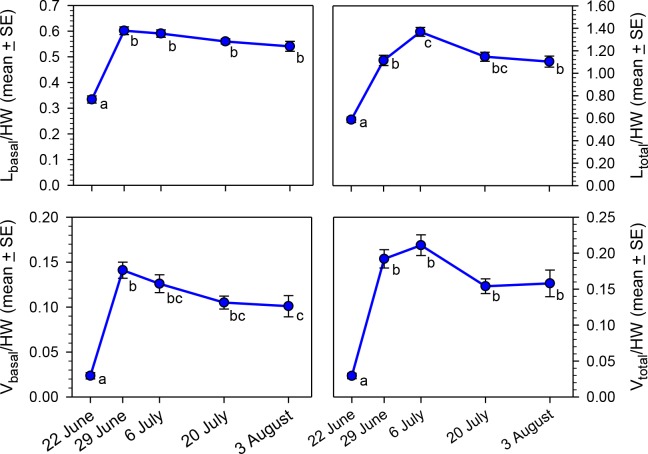
Seasonal changes in body size-adjusted oocyte size variables by sampling date for bees collected in MT in 2012.Means associated with different letters are significantly different at P < 0.05 (Dunn’s Test). Samples sizes for each date were N = 30 for 22 June, N = 26 for 29 June, N = 32 for 6 July, N = 27 for 20 July, and N = 30 for 3 August.